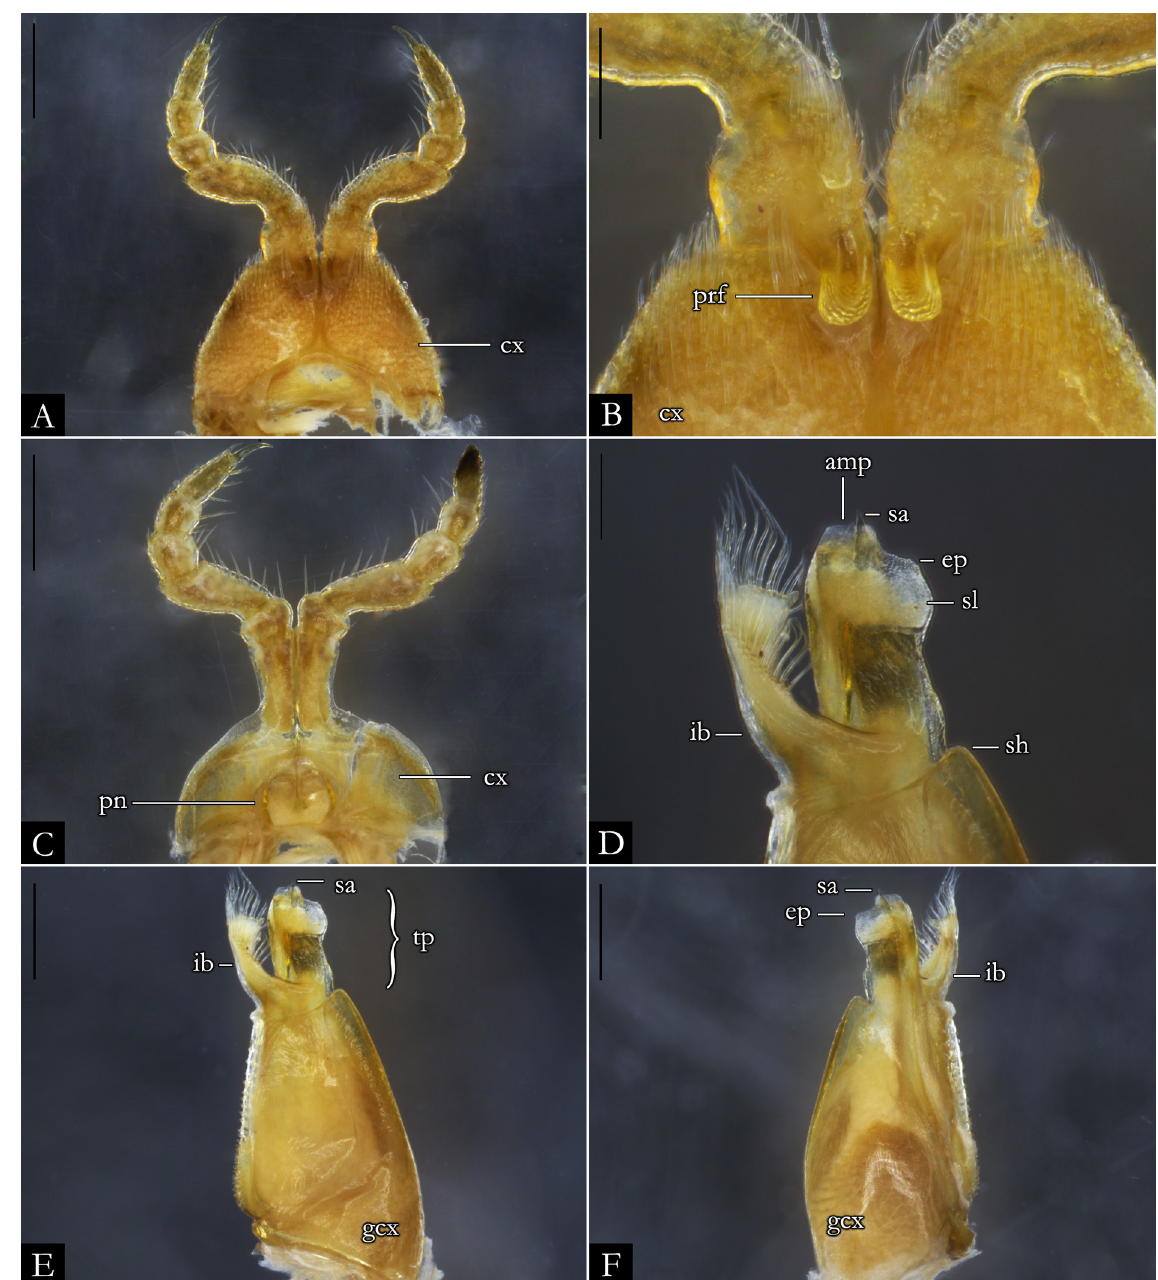
Fig. 137. Pseudonannolene typica Silvestri, 1895, holotype, ♂ (MCSN). A . First leg-pair. B . Detail of prefemur. C . Second leg-pair. D . Detail of telopodite, in anal view. E . Left gonopod, in anal view. F . Left gonopod, in oral view. Abbreviations: see Material and methods. Scale bars = 0.5